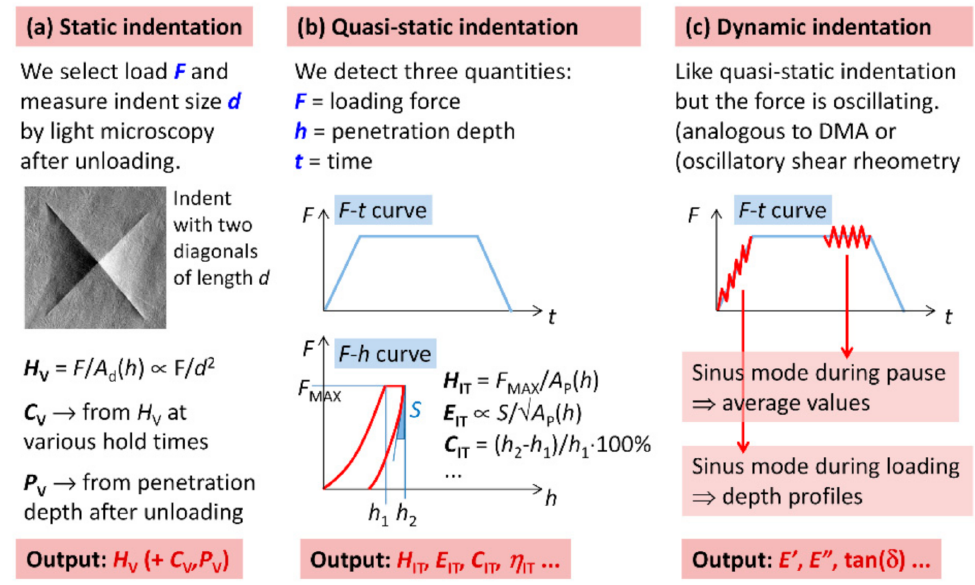
Figure2. Schemeshowingthreebasictypesofindentationexperiments(static, quasi-static, anddynamic) and the most important micro- or nanomechanical properties that can be obtained from the experiments. Typical static indentation experiments yield microhardness ( H v ) and special types of experiments can also provide microcreep ( C v ) and microplasticity ( P v ). Quasi-static indentation experiment yield indentation hardness ( H IT ), indentation modulus ( E IT ), and several supplementary properties, such as indentation creep ( C IT ) and elastic part of the indentation work ( η IT ). Dynamic indentation experiments yield parameters analogous to macroscopic dynamic mechanical analysis: storage modulus ( E (cid:48) ), loss modulus ( E ”), and damping factor (tan( δ